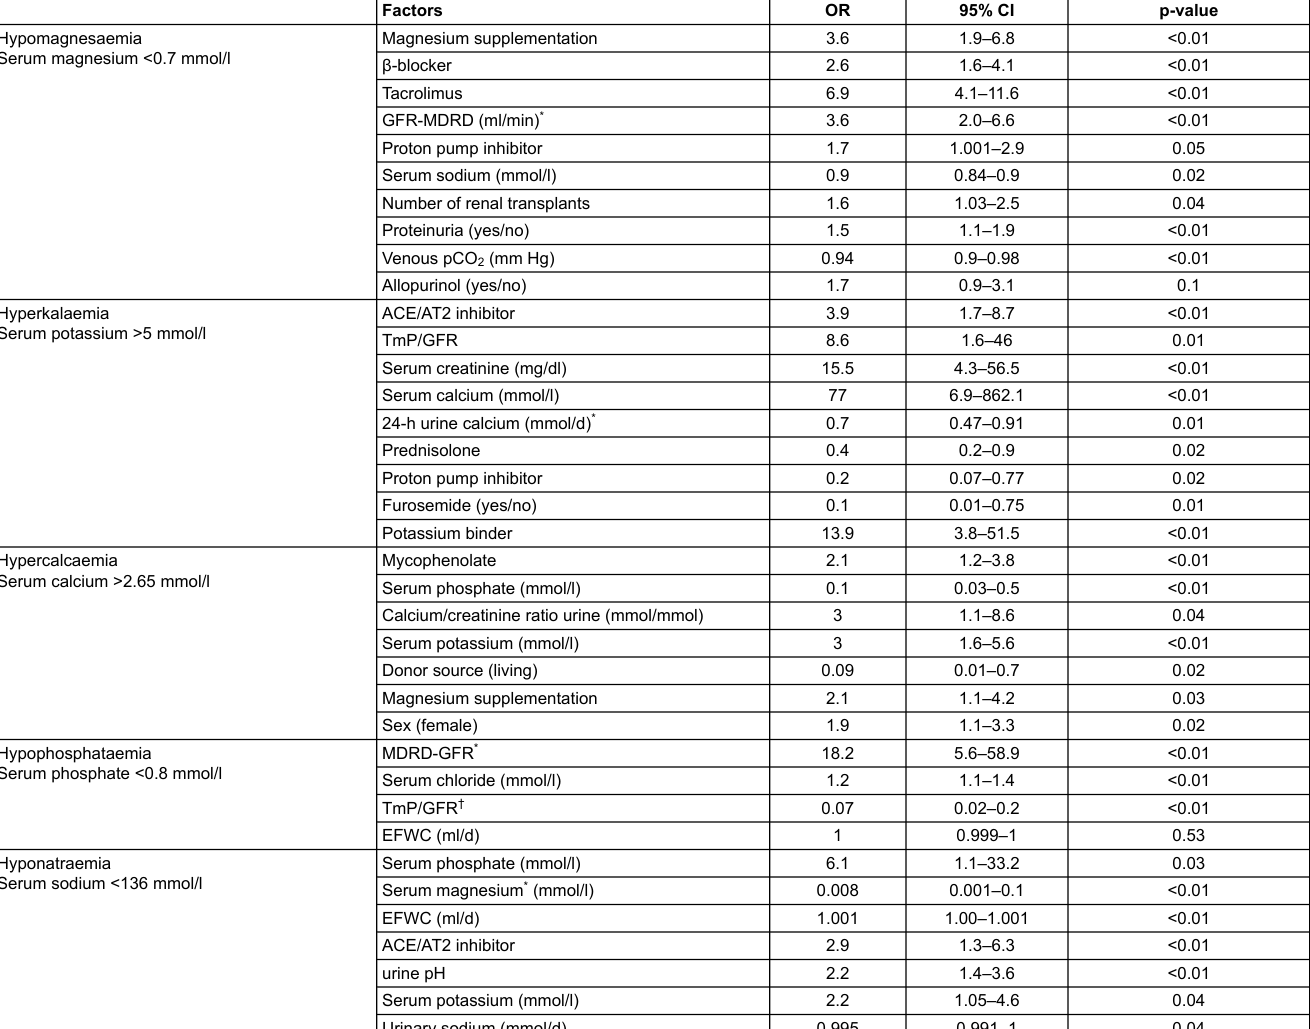
Table 3: Independent predictors of electrolyte